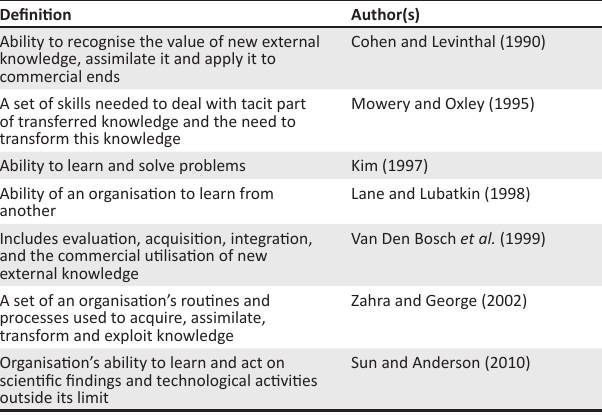
TABLE 1: Definitions of Absorptive Capacity